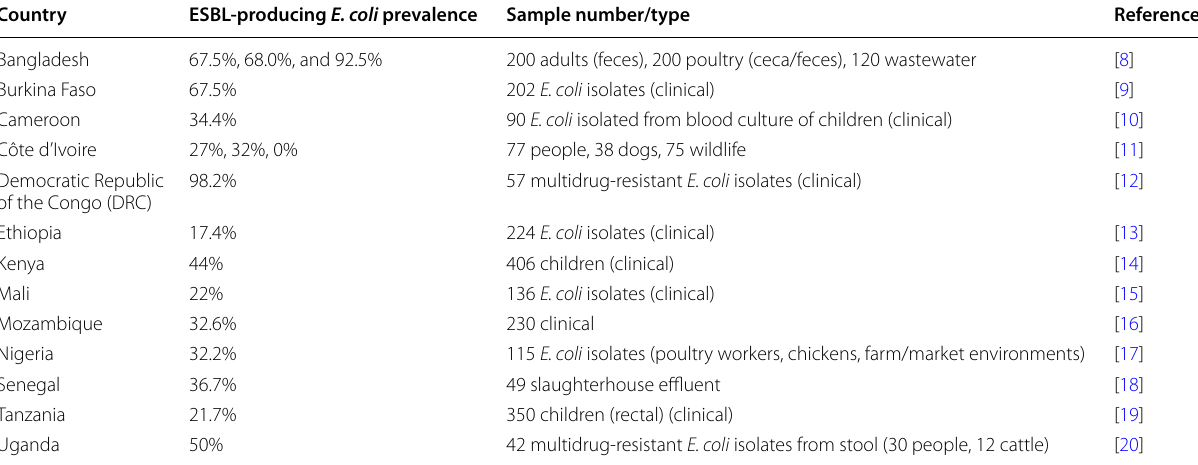
Table 1 Prevalence of ESBL production in E. coli isolates from 13 target country studies